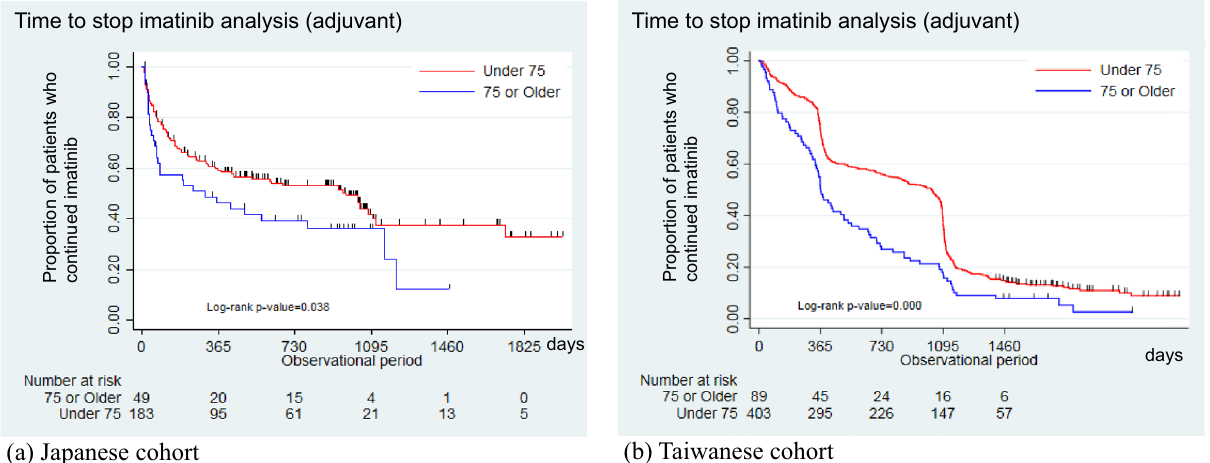
Figure 2. Time to stop imatinib in the older and non-older patients who received adjuvant treatment. ( a ) Japanese cohort. ( b ) Taiwanese cohort.